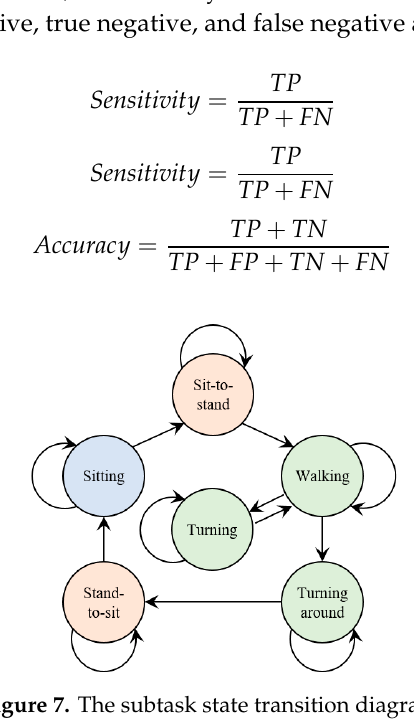
Figure 7. The subtask state transition diagram.